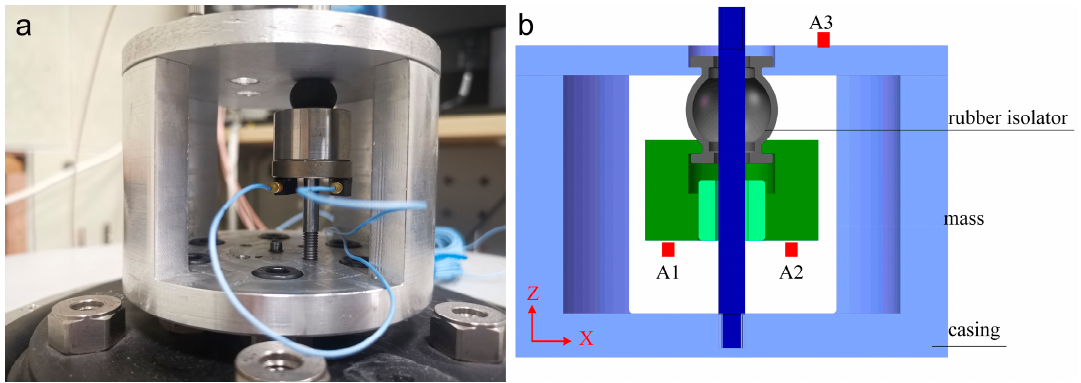
Figure 3. ( a ) Photo of the experimental setup; ( b ) schematic diagram of the rubber isolator structure. The vibration experiment adopted the average control method. The control signal was a single channel. The test signal was a dual channel. The nonlinear characteristics of rubber isolators under harmonic and random vibrations were tested. For harmonic vibrations, experiments were carried out by changing the acceleration excitation levels.